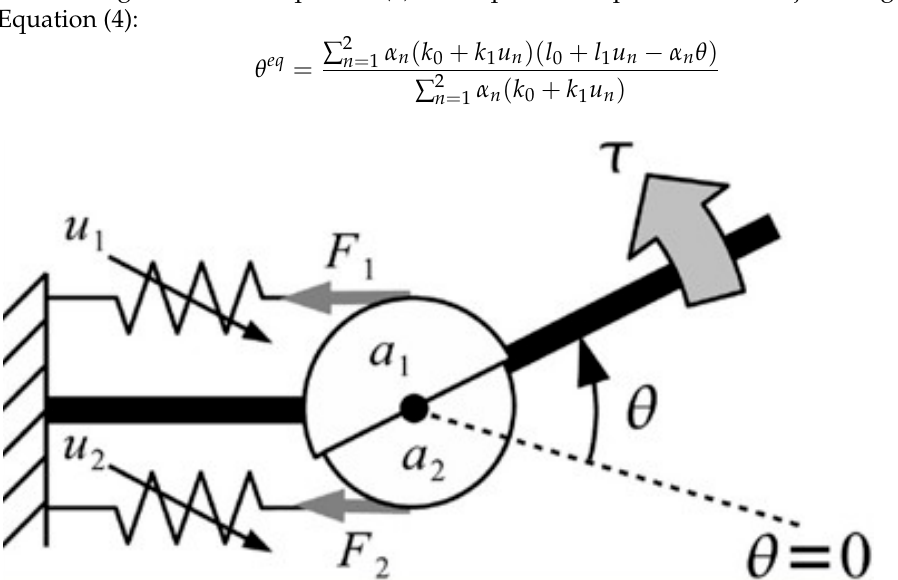
Figure 4. Structure of MSM [17]. u n represents the motion instruction to the muscle, F n represents the force generated when the muscle is contracted, α n represents the moment arm of the joint, and τ represents the torque of the joint. Because of its elasticity, when a muscle contracts, force is generated in the joints. It is assumed that the joint angle is equal to the angle of the mechanical equilibrium point of the musculoskeletal system.